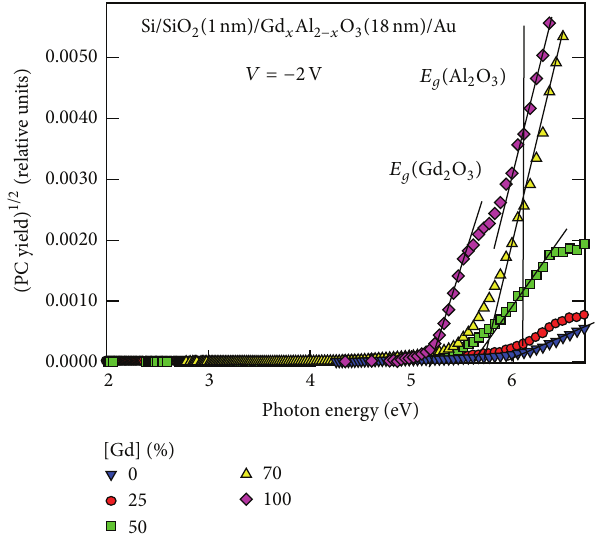
Figure 11: Square root of the PC yield as a function of photon energy in Si/SiO 2 /Gd 𝑥 Al 1−𝑥 O 3 /Au capacitors with different concentration of gadolinium in the insulating